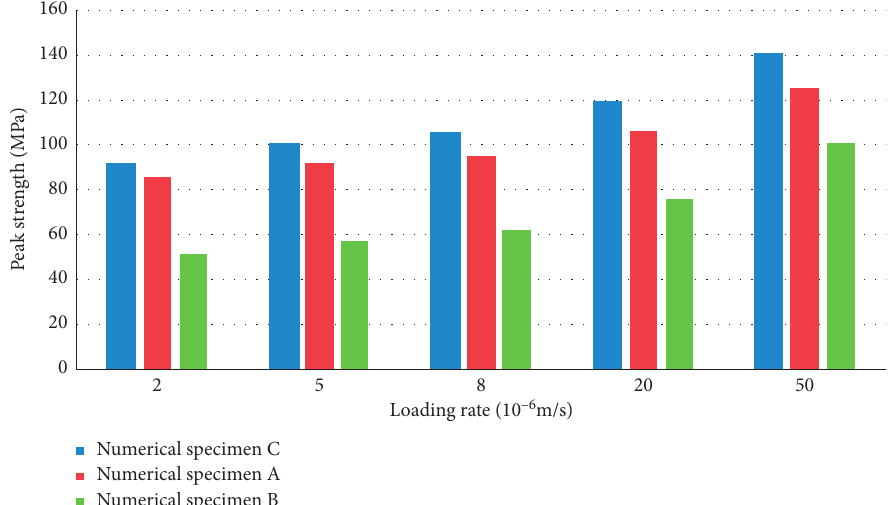
Figure 8: Longitudinal contrast of peak strength of three kinds of numerical specimens.